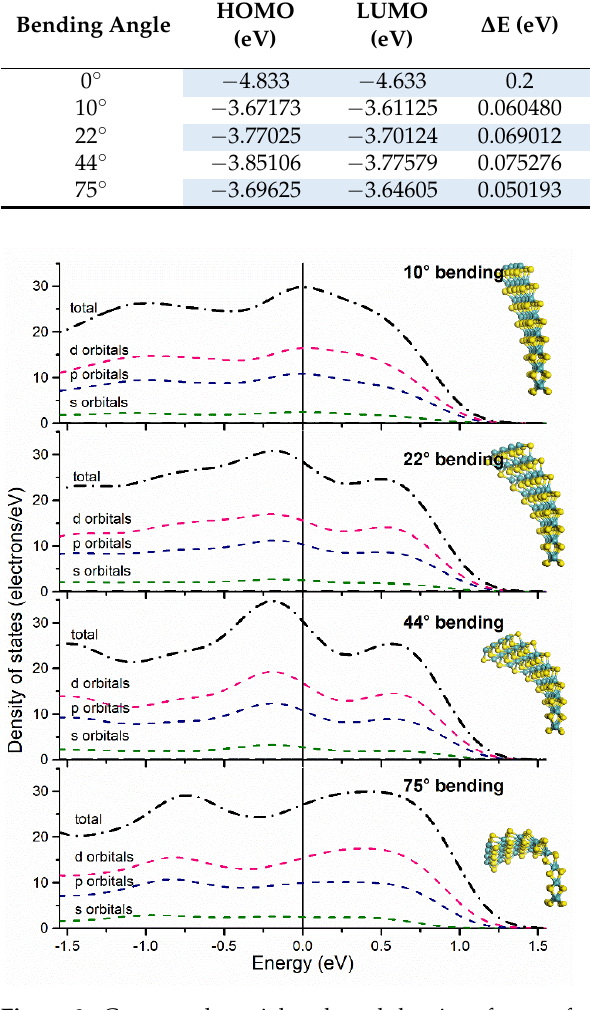
Figure 3. Computed partial and total density of states for all bending curvatures angles plotted near the Fermi energy level set at 0 eV. Data indicate the electronic structure crosses E F which is characteristic of semi ‐ metallic and metallic electronic structures, the transition highly discussed by others [17,26,27]. Table 2. The HOMO and LUMO computed values (units eV) for bending angles. Δ E is the energy difference between HOMO and LUMO levels. DOS integration was computed from ‐ 0.5 eV to 0.5 eV.